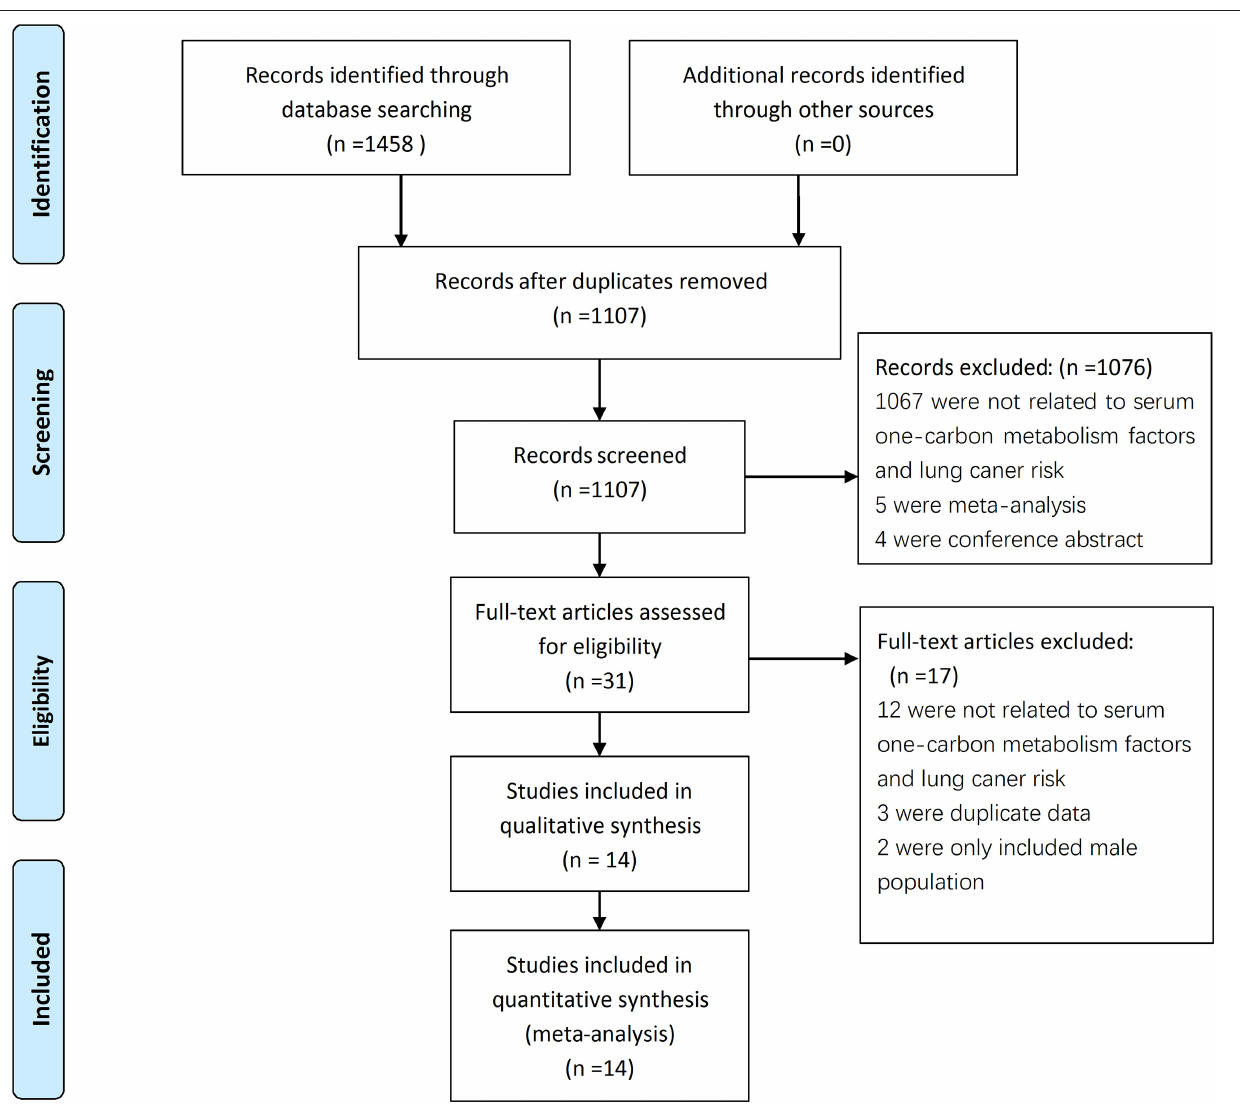
FIGURE 1 | Flow chart of the study selection